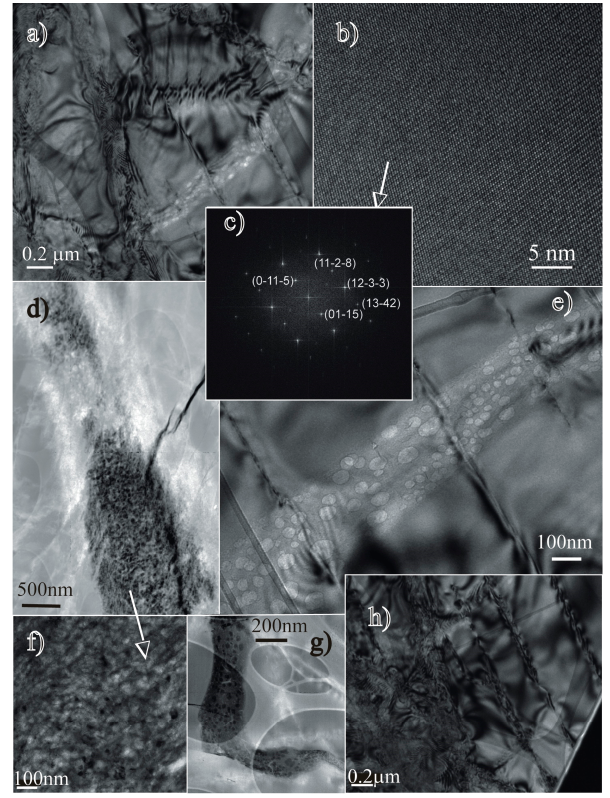
Figure 8. Transmission Electron Microscope ( TEM) photomicrographs of the i ( a ) Bright field (BF) image of the merrillite with a trail of “bubbles” in the lower part of the image (for comparison, refer to the magnified portion with some planar deformation across the trail – image “e”); ( b – c ) lattice fringe image and the corresponding diffraction pattern (FFT) (note the perfect regular structure of the crystal domain without any sign of distortion); ( d,e,f ) recrystallized melt pockets (d, f) and a trail of “bubbles” (e – magnification of image “a”), which shows no offset by the planar features, which suggests a later formation event; ( g ) L–shaped porous domain that shows traces of volatiles (big elipsoids-copper grid holder); and ( h ) disturbed crystal domain (the right side of the picture demonstrates the planar deformations).